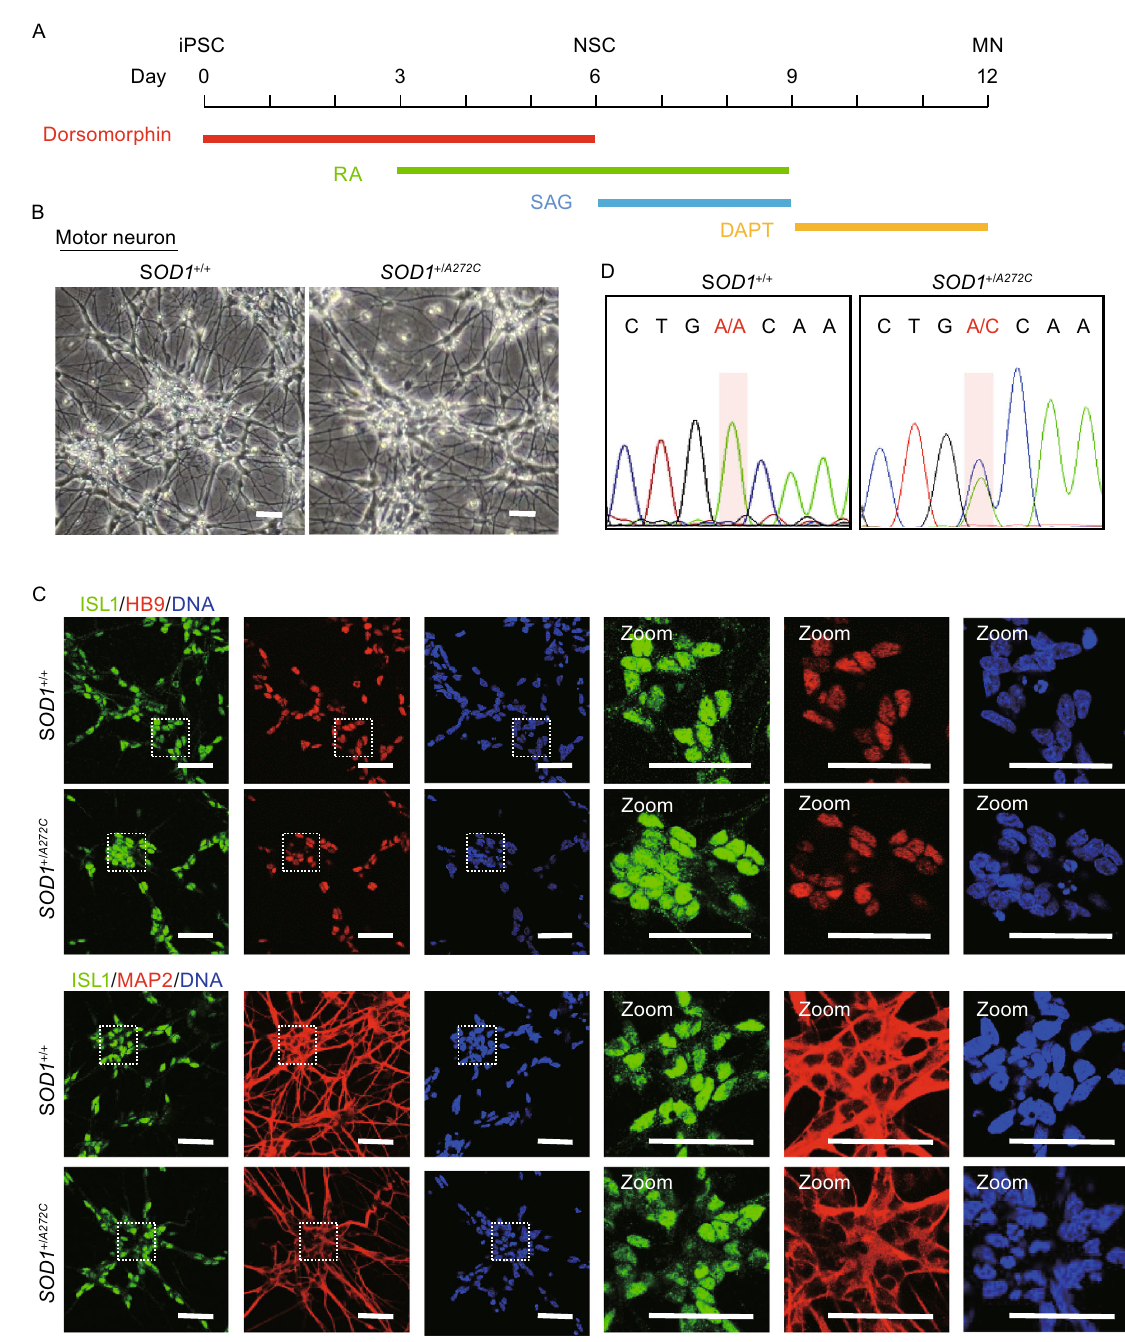
Figure 3. Directed motor neuron differentiation from isogenic pair of iPSC lines. (A) Schematic overview of motor neuron differentiation from iPSCs. Compounds are added at different time points as indicated. NSC, neural stem cell. MN, motor neuron. (B) Phase contrast images of motor neurons derived from SOD1 +/ A272C iPSCs and its isogenic control iPSCs at day 12. Scale bars = 75 μ m. (C) Immuno fl uorescent images of motor neuron markers (ISL1, HB9) and other neural marker (MAP2) at day 12. Nuclei were stained with Hoechst 33342 (blue). Scale bars = 50 μ m. (D) DNA Sequencing con fi rming SOD1 genotype in motor neurons derived from SOD1 +/ A272C iPSCs and its isogenic control iPSCs at day